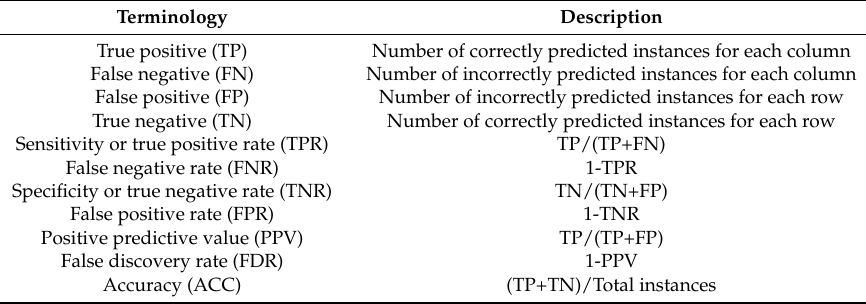
Table 9. Terminology and derivations of the confusion